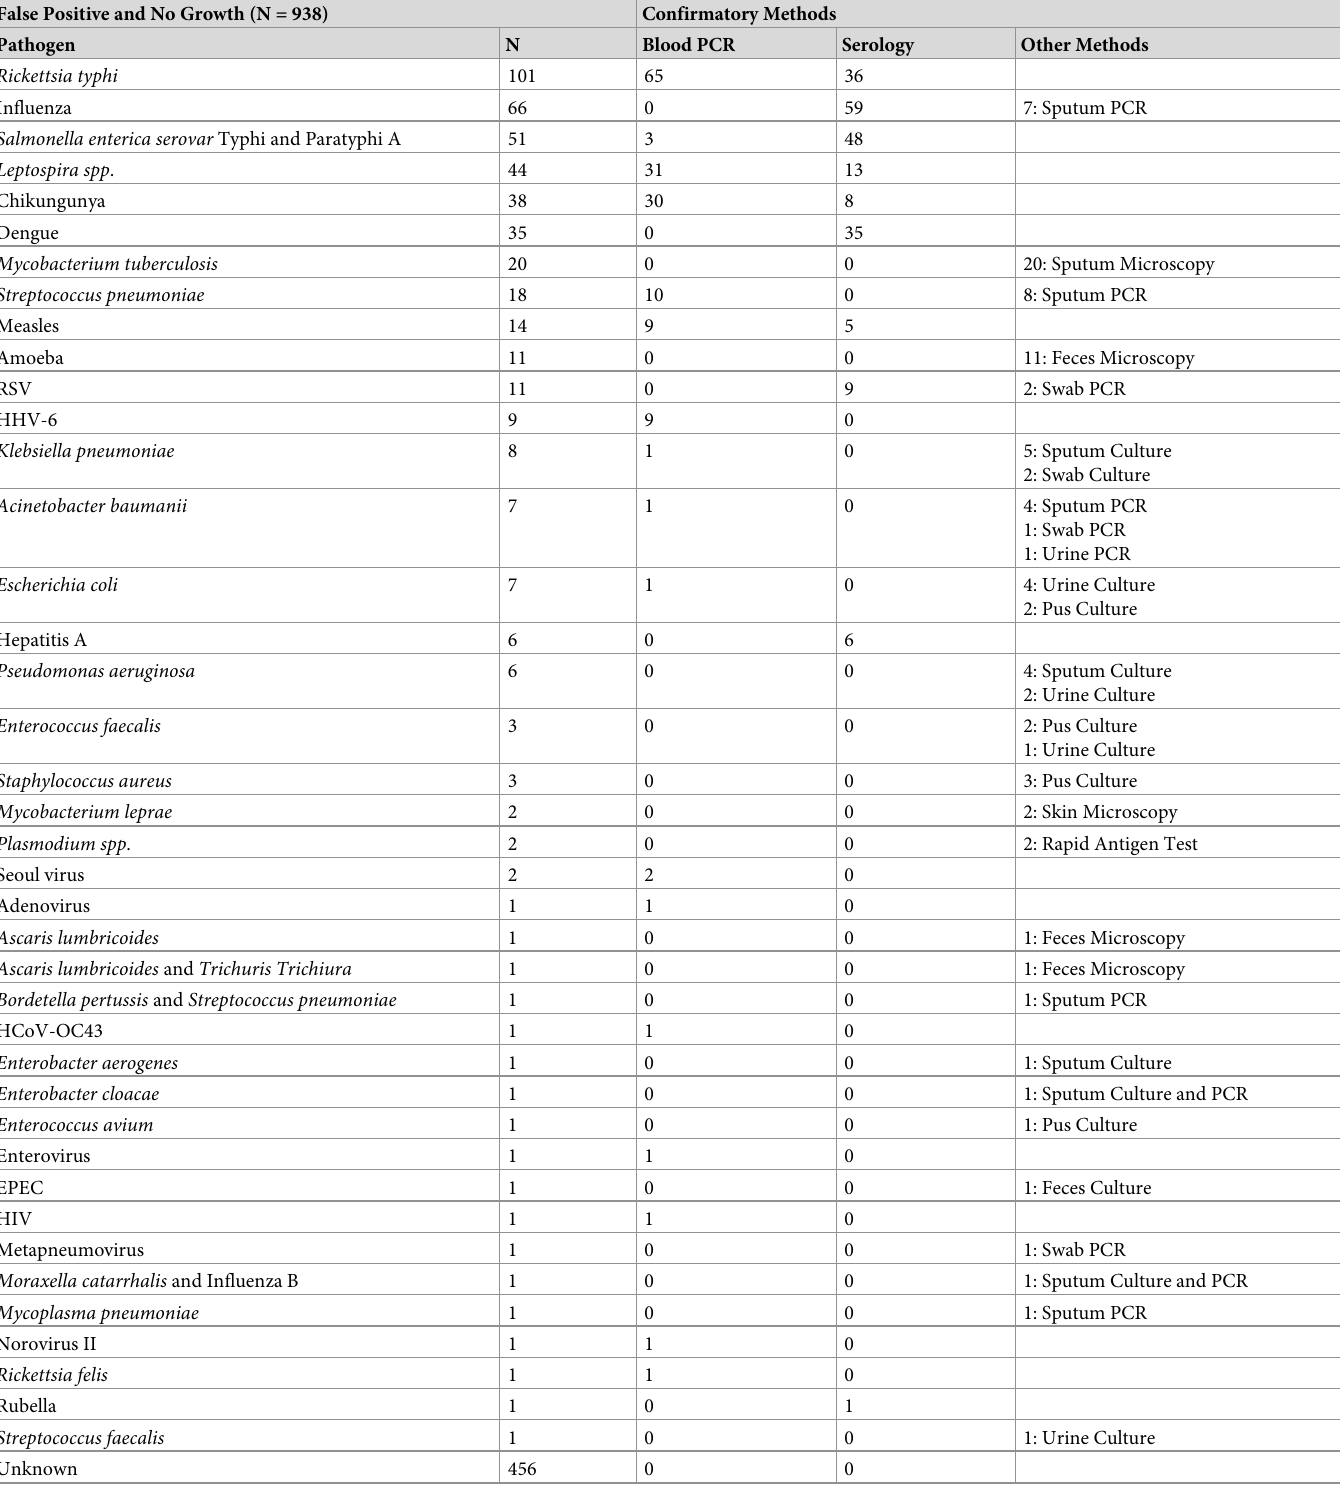
Table 4. Pathogens detected by molecular, serological, or other laboratory methods from participants with false positive and no growth blood cultures. False Positive and No Growth (N =